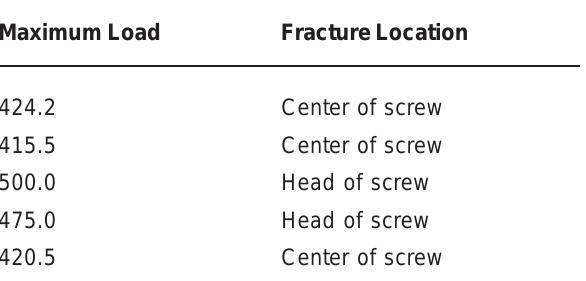
TABLE 1- Maximum load (N) during implant compression and fracture